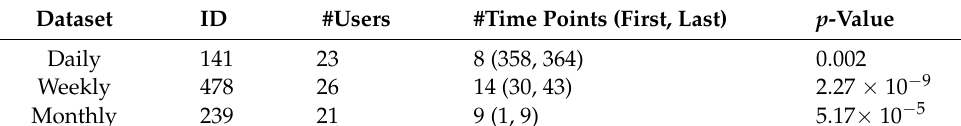
Table 7. Biclusters accommodating shifting factors (L = 4) picked for each of the datasets.